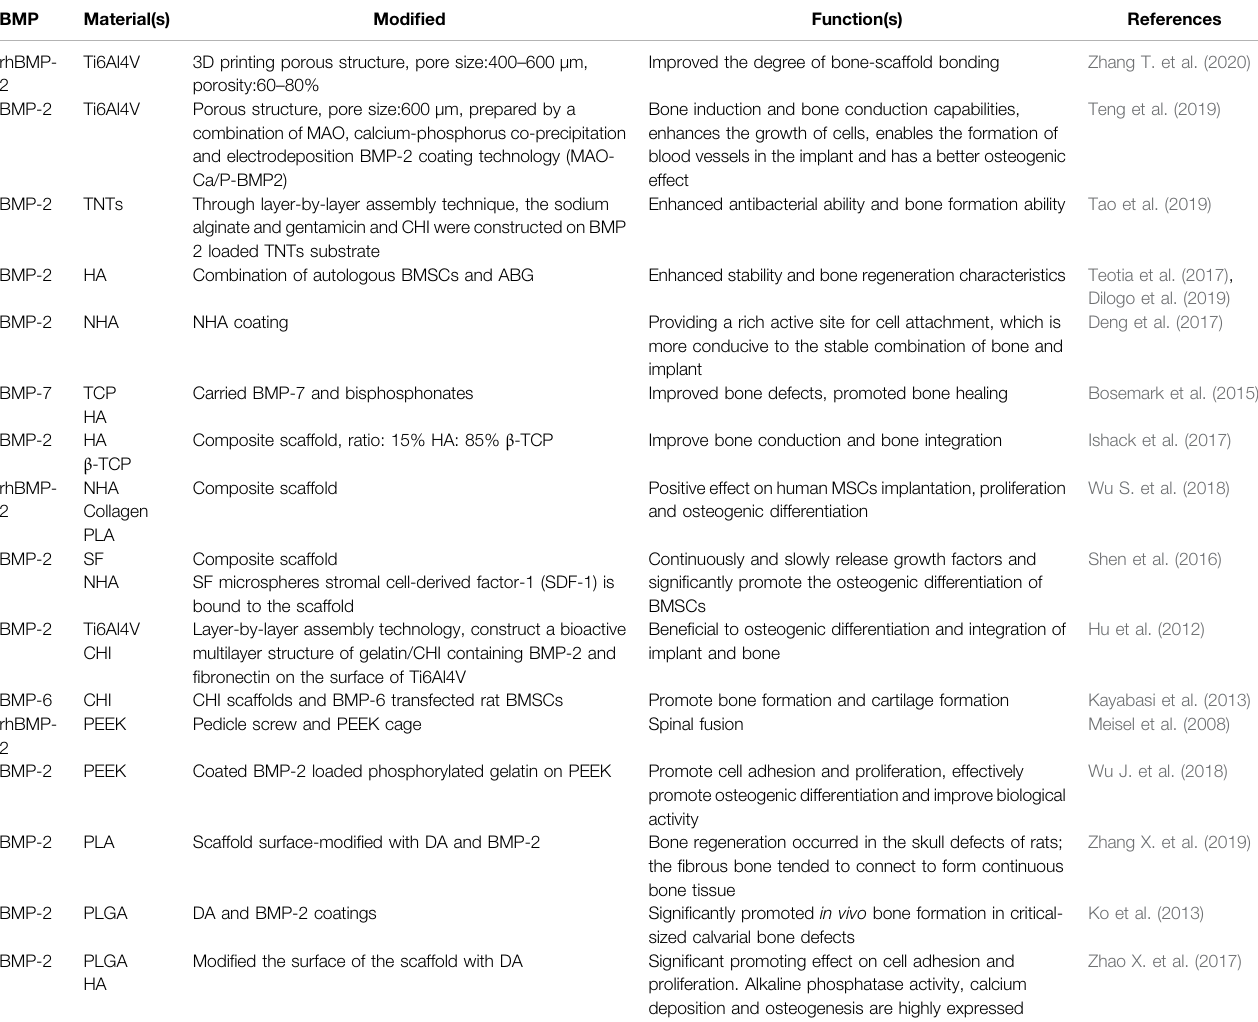
TABLE 4 | The application of BMPs in